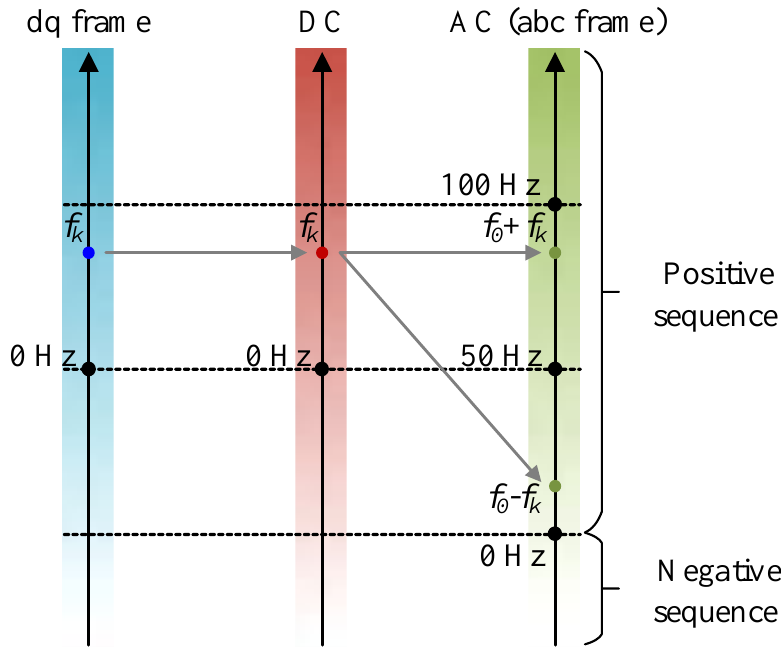
Figure 4. Propagation path of the resonant frequency in the AAC